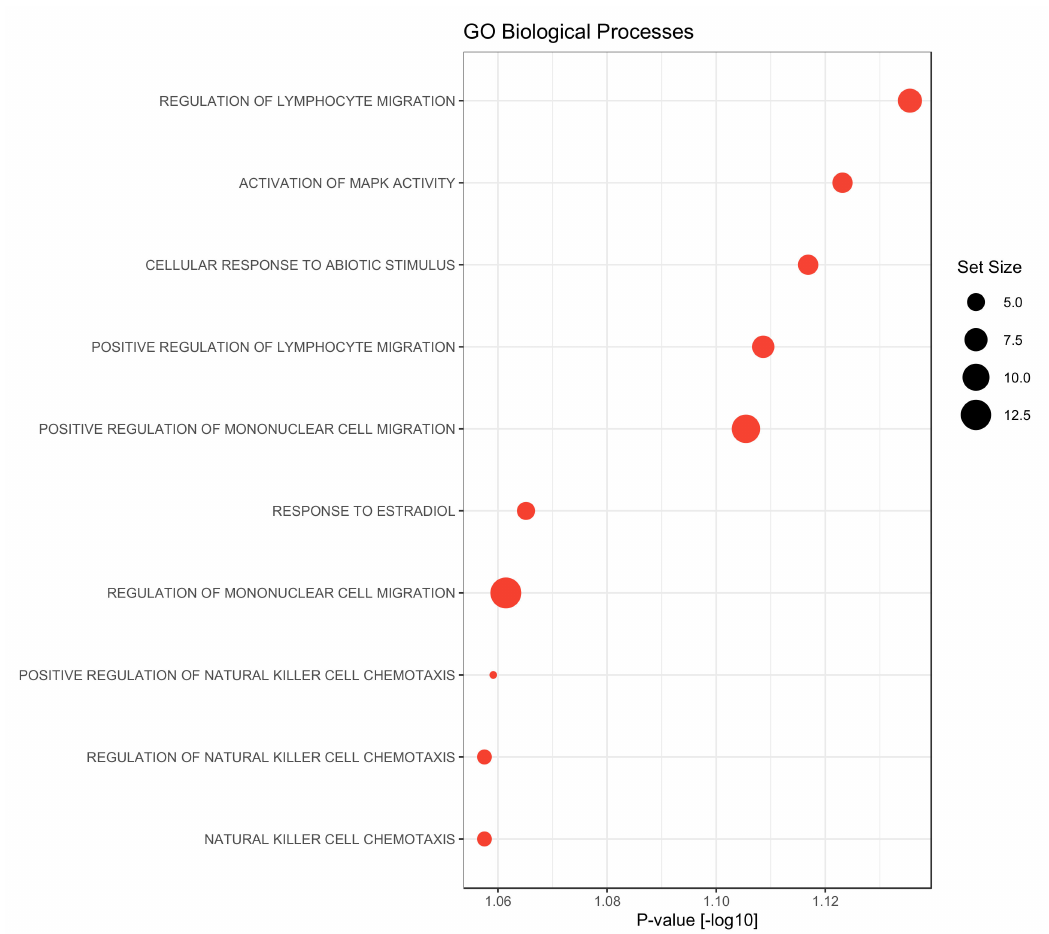
Figure 5. Gene Set Enrichment analysis on biological processes gene sets of the gene ontology (GO) of proteins up-regulated in PDAC patients with late hepatic metastatic spread (LHMS) compared to early hepatic metastatic spread (EHMS). Gene set enrichment was performed using R-library gage (version 2.44) based on the fold change differences between the LHMS and EHMS groups. Gene sets containing at least 3 proteins were considered, only. Dot diameters correspond to the gene set